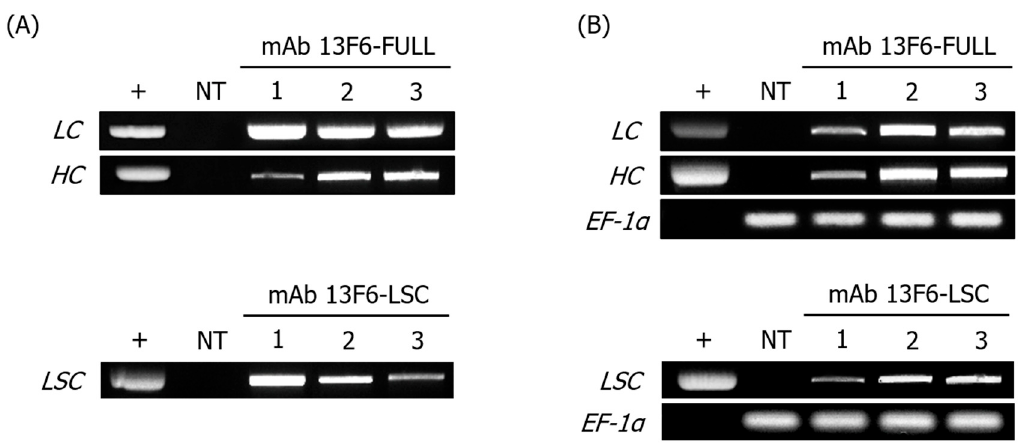
Figure 2. PCR and RT-PCR analyses of transgenic LC, HC, and LSC in gDNA and mRNA of the transgenic plant expressing mAbs 13F6-FULL and 13F6-LSC. ( A ) PCR analysis was performed to confirm the existence of LC and HC of mAb 13F6-FULL and LSC of mAb 13F6-LSC gene construct in